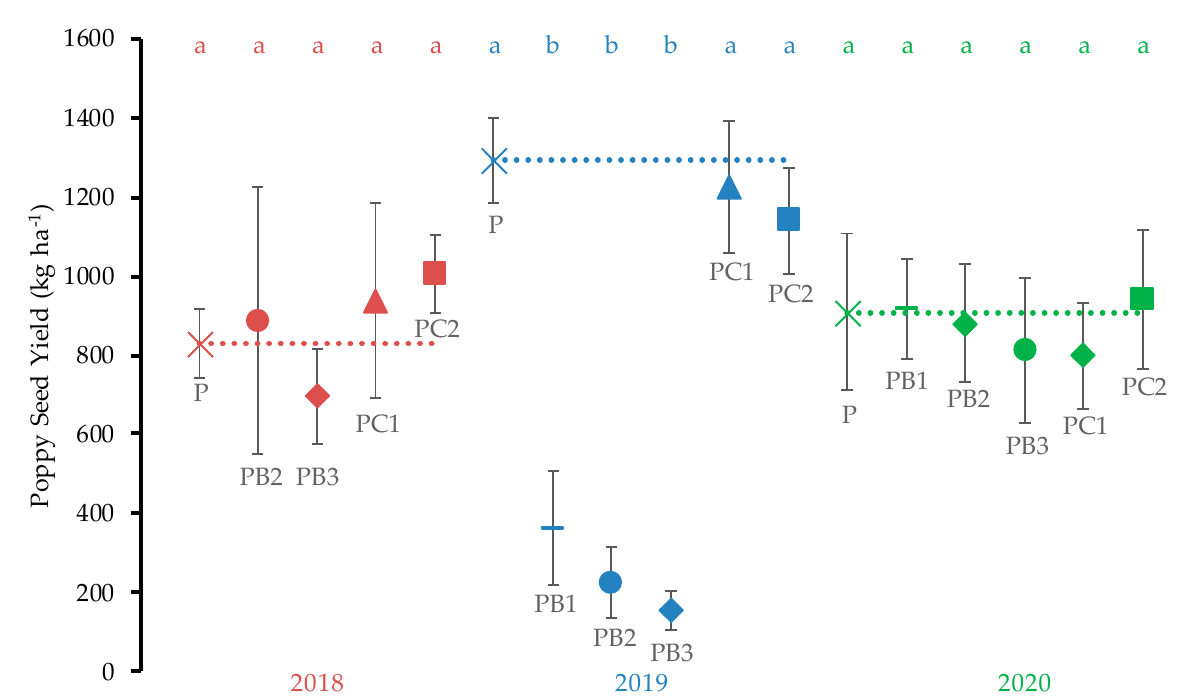
Figure 1. Poppy sole crop seed yield (P) compared to poppy yield intercropped with barley for three sowing densities (PB1 (not in 2018), PB2, PB3) and white clover for two sowing dates (PC1, PC2) in three consecutive years (2018–2020). Means and standard deviations are given for each treatment in each year. Lower case letters indicate significant differences between treatments in each year (ANOVA + Tukey HSD test). Table 5. Poppy yield data from sole cropping (P) and intercropping with barley for three different sowing densities (PB1 (not in 2018), PB2, PB3) and white clover for two sowing dates (PC1, PC2) at Campus Klein-Altendorf 2018–2020. Lower case letters indicate significant differences between crop treatments for each yield parameter in each year (ANOVA & Tukey HSD test, p < 0.05).